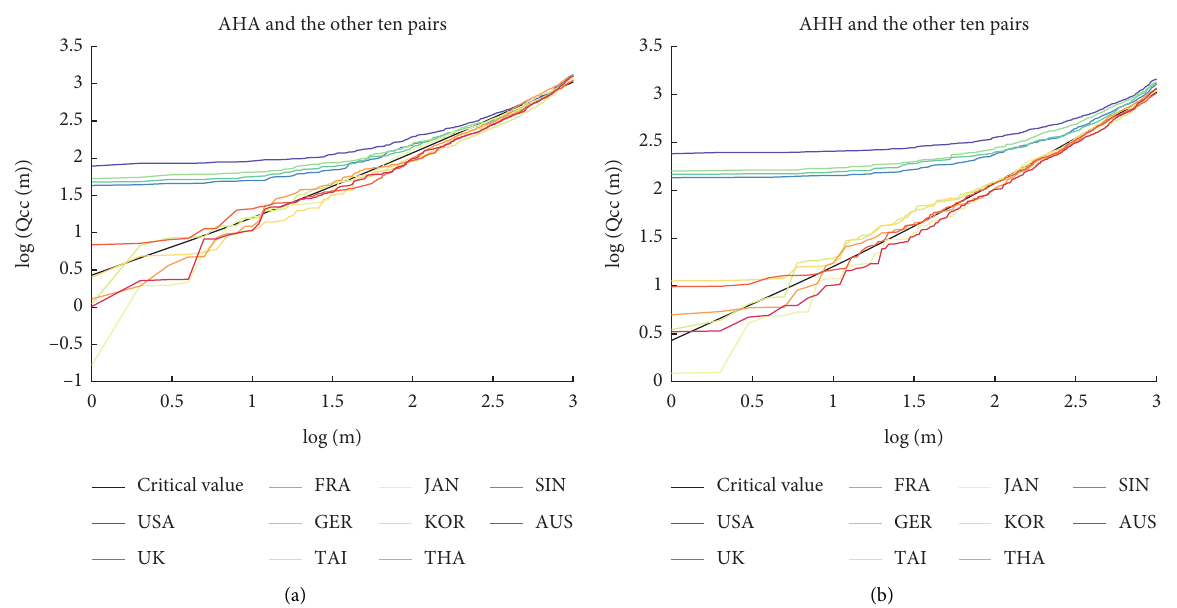
Figure 1: The cross-correlation statistic between AHA, AHH, and the other ten indices prices returns series (e.g., USA, UK, FRA, and GER) for the overall period with the degree of freedom varying from 1 to 1000. Note: this figure shows the cross-correlation statistic; in each subplot, the left one shows the statistic result of AHA with the other ten pairs and the right one exhibits the AHH’s. The black line corresponds to the critical value (at 10% significance